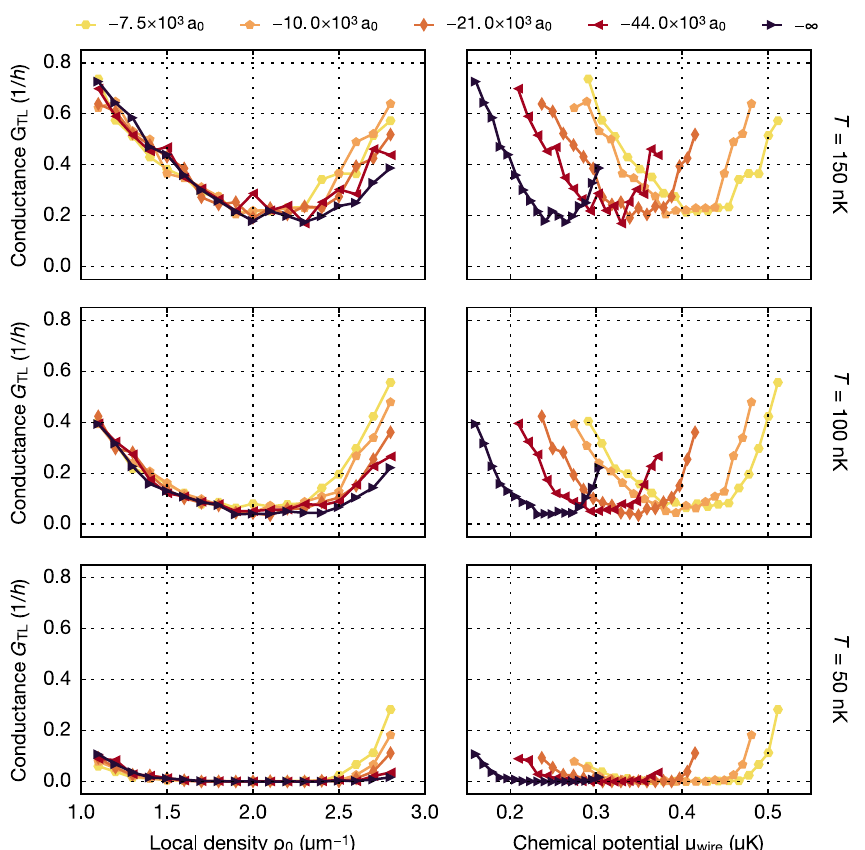
FIG. 10. Conductance G obtained from Tomonaga-Luttinger theory for one spin species in units of the conductance quantum 1 =h as TL a function of the mean 1D density ρ 0 in the wire (left) and the local chemical potential in the wire μ (right) for the scattering lengths wire used in the experiment. All curves have a minimum around ρ 0 ¼ 2 μ m − 1 , which is the filling of a band insulator in the noninteracting limit. Stronger interactions decrease conductance and tend to “ widen ” the conductance minima when plotted as a function of 1D density, which can be explained by the renormalization of the potential due to spin fluctuations towards larger effective lattice